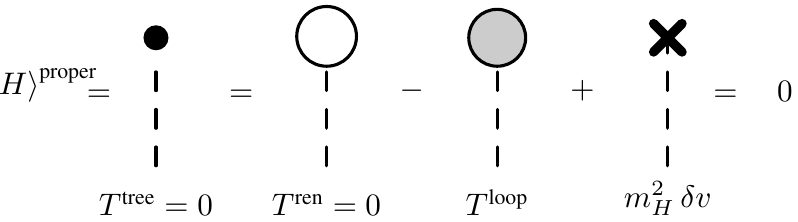
Figure 1 . Renormalization condition in the alternative tadpole scheme: with the neutral com- p ponent (cid:8) 0 of the Higgs doublet (cid:8) de(cid:12)ned as (cid:8) 0 = ( v + H ) = 2, the requirement for the VEV to represent the true minimum of the Higgs potential translates into h H i proper = 0 or, equivalently, the renormalized tadpole graph (white blob) to vanish. The proper VEV coincides with the tree-level VEV ((cid:12)xed by the condition T tree = 0). Together with the condition T ren = T tree = 0, this relates the tadpole loop diagram (grey blob) at a given loop order to the VEV